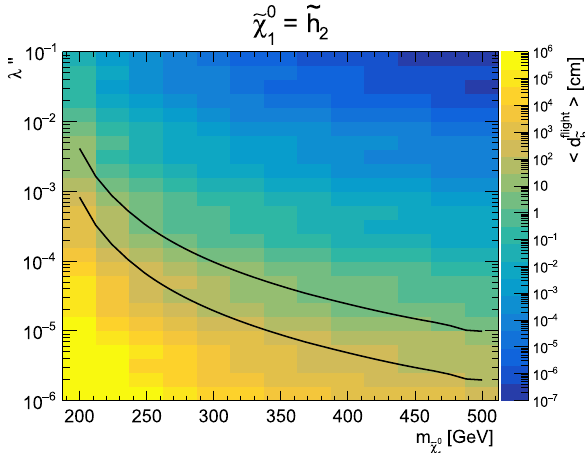
m ˜ μ have been investigated for the slepton production. For